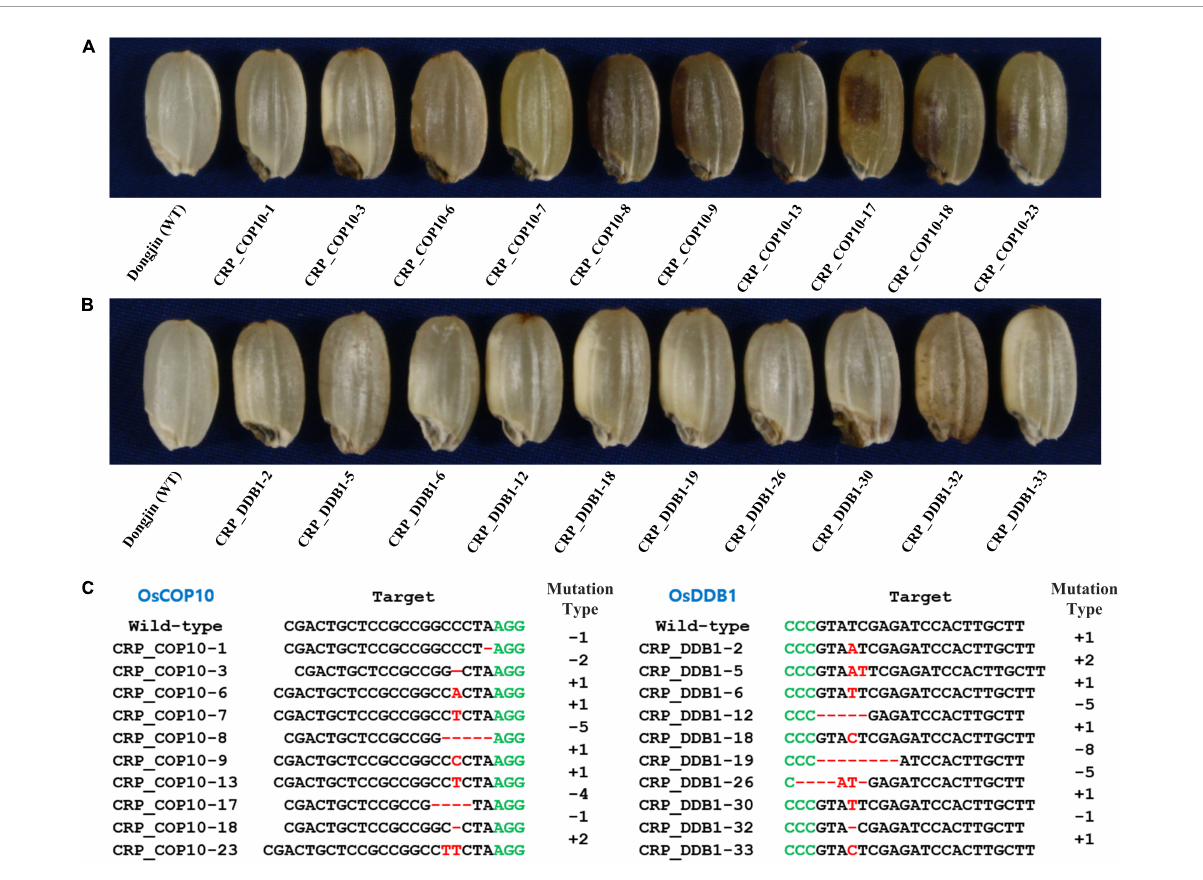
FIGURE4 Grain phenotypic analysis and sequence analysis of CRISPR/Cas9-induced knockout yel mutants generated by targeting OsCOP10 and OsDDB1 genes. (A,B) Grain phenotype of Dongjin (WT) seeds and CRISPR mutant seeds generated by targeting OsCOP10 (A) and OsDDB1 (B) . Grains showing the yel phenotype were randomly selected from each positive T 0 transgenic plant. (C) Sequence comparison of OsCOP10 ( LOC _ Os07g38940 / Os07g0577400 ) and OsDDB1 (LOC _ Os05g51480 / Os05g0592400 ) target regions in the WT and mutants. The first exon of OsCOP10 and second exon of OsDDB1 were targeted to induce mutations. Red dashes and letters indicate deletions and insertions, respectively, in transgenic lines. Black and green letters indicate the target sequence and PAM, respectively. Mutation types are shown to the right of each mutated sequence (-, deletion; +,